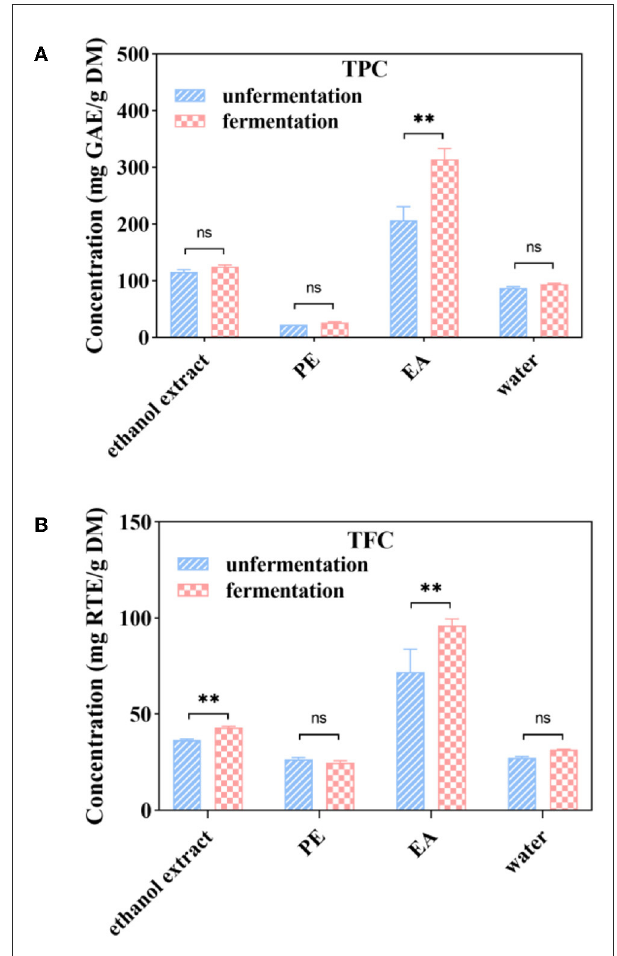
FIGURE2 Soluble phenolic contents (A) , soluble flavonoid contents (B) and soluble phenolic extracts at different subfractions from Apocynum venetum L. (AVL) fermented with A. niger . ** P <